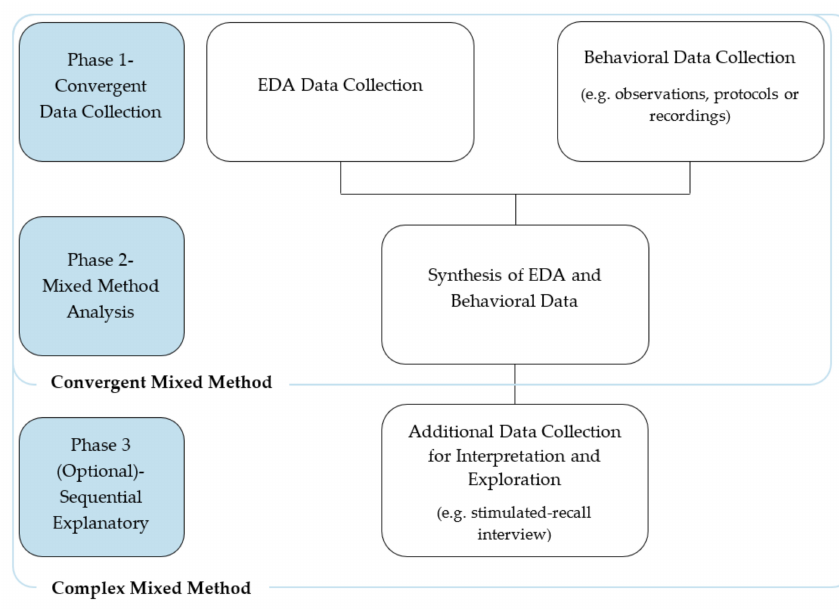
Figure 1. Method